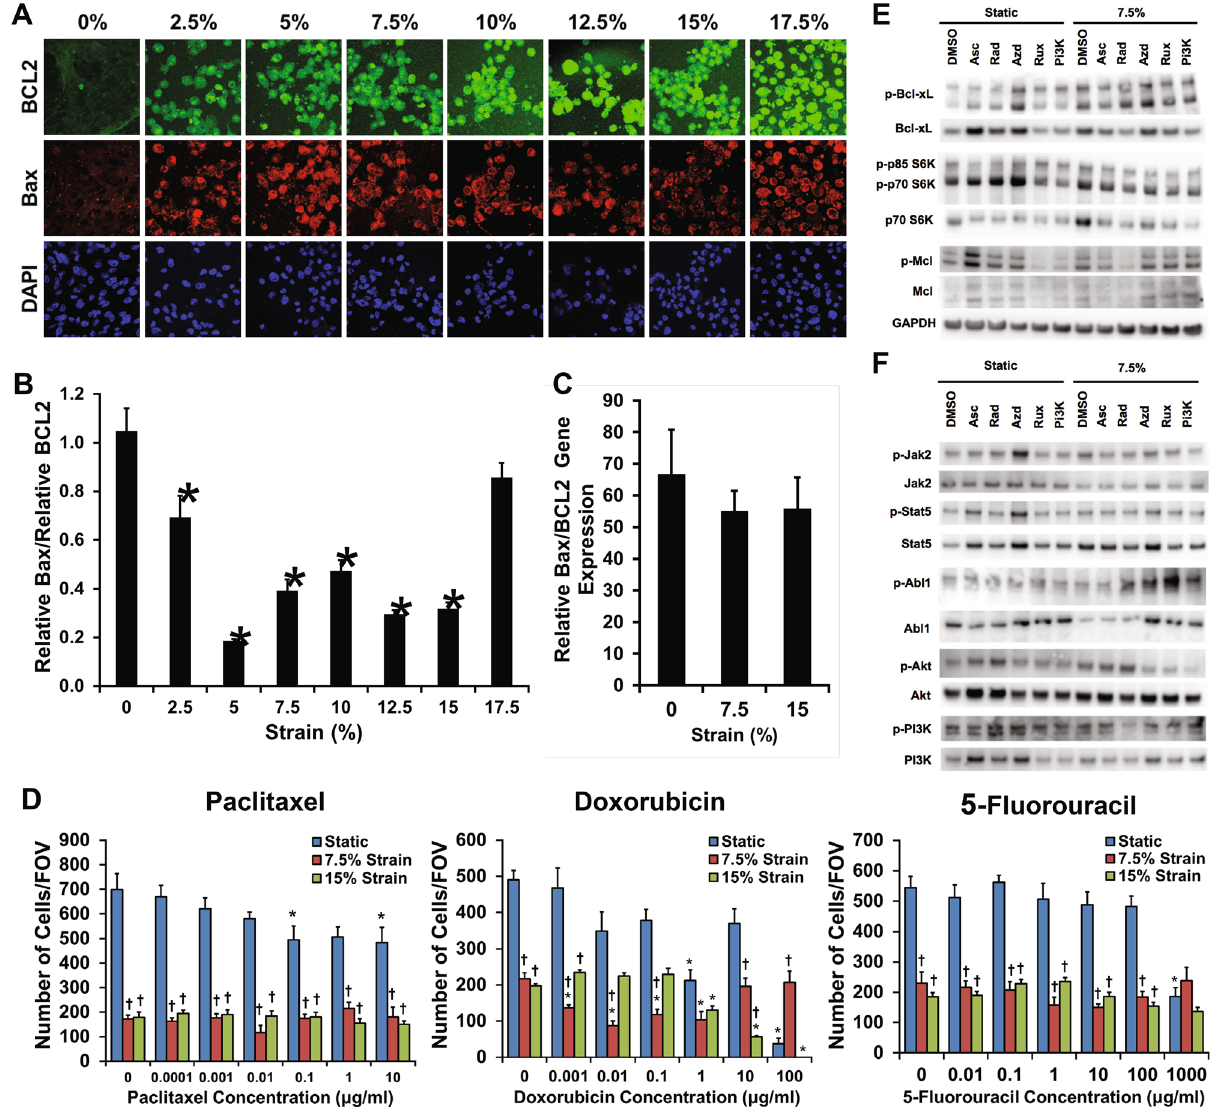
Figure 2. Mechanical strain decreases proliferation and increases drug resistance in breast cancer cells. ( A ) Images of Bax and Bcl-2 immunostaining for cyclic mechanical strains of 0–17.5% strain. Bar = 100 μm. ( B ) Relative expression of pro-apoptotic Bax to anti-apoptotic Bcl-2 protein expression. * p < 0.05 versus 0% strain (n = 10). ( C ) Relative gene expression of Bax to Bcl-2 after 24 h of mechanical strain (n = 10). ( D ) Response of MDA-MB-231 breast cancer cells to drug treatment with paclitaxel, doxorubicin, or 5-fluorouracil under 0%, 7.5%, or 15% mechanical strain (n = 8). * p < 0.05 versus static conditions. † p < 0.05 versus static conditions under no treatment and under static conditions with the pharmacological treatment with same concentration as the indicated group. ( E ) Western blotting for cells treated with 7.5% strain in combination with DMSO, asciminib (Asc; Abl1 inhibitor), radotinib (Rad; c-Abl1 inhibitor), AZD1480 (Azd; Jak2 inhibitor), Ruxolitinib (Rux; Jak1/2 inhibitor), or a PI3K inhibitor (PI3K). ( F ) Western blotting for cells treated with 7.5% strain and the indicated inhibitors. Full-length blots/gels are presented in Supplemental Figs.